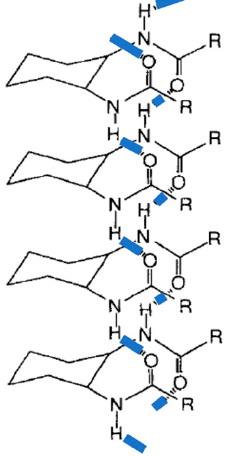
Figure 2. Suggested model to explain the helicoidal aggregates from 1 . Adapted with permission from Wiley [27].